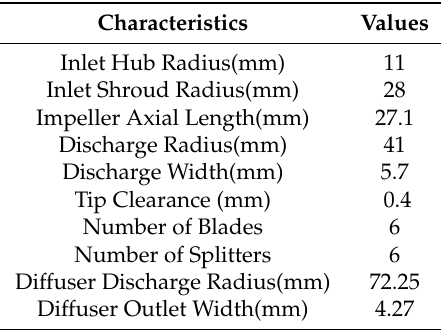
Table 2. Geometry